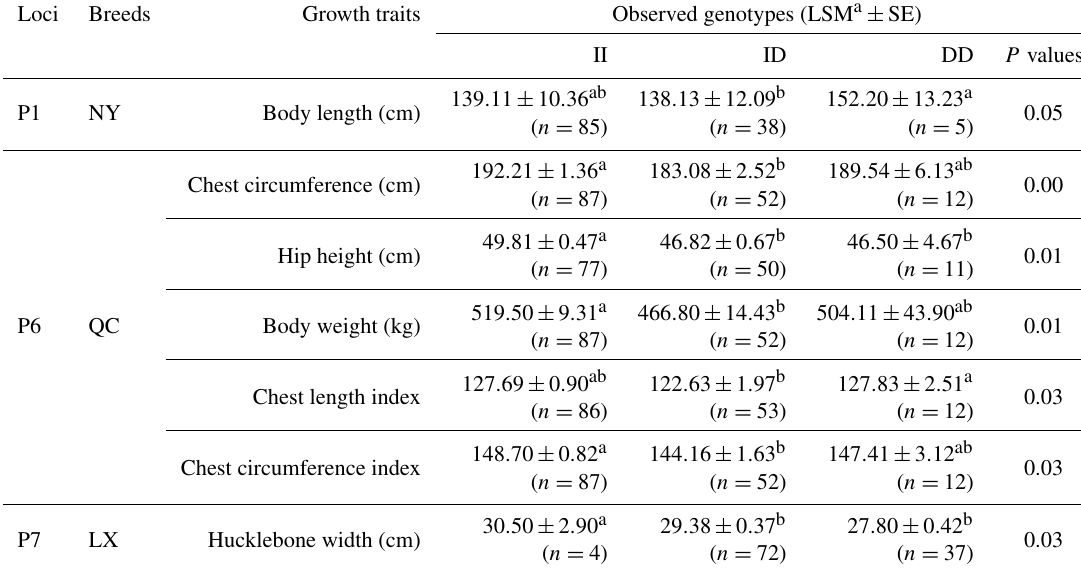
Table 5. Three novel indels in MSRB3 gene and their associations with growth traits. Loci Breeds Growth